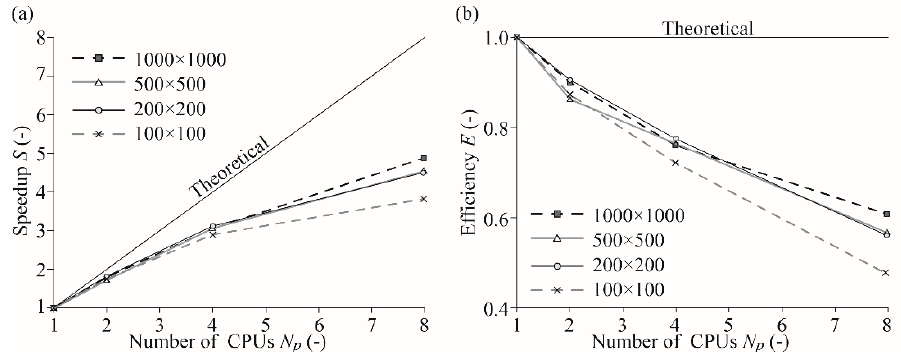
Figure 11. Dependency of ( a ) speed up and ( b ) efficiency on the number of processors applied in the CPU for parallel computations.